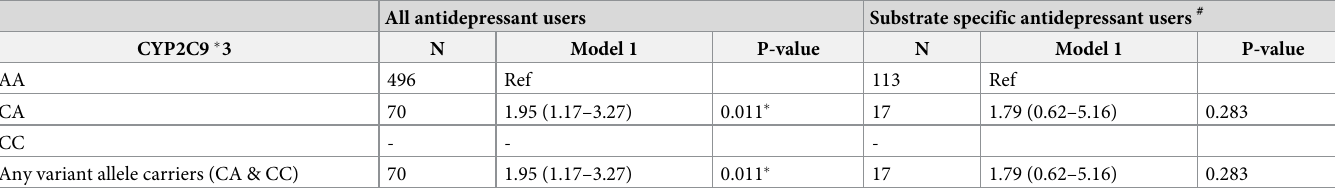
Table 3. Association between CYP2C9 � 3 and fall risk within antidepressant users.